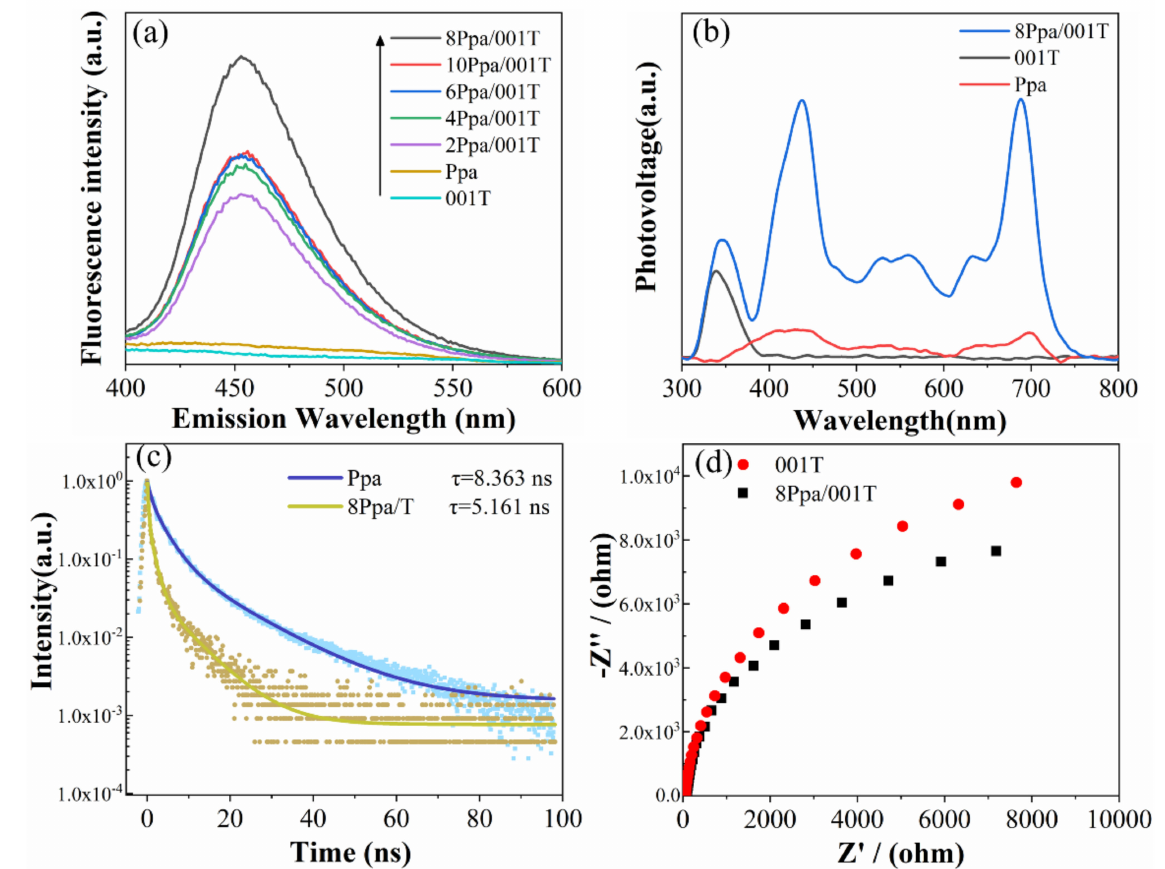
Figure 4. ( a ) FS spectra of the • OH radical over the 001T, Ppa, and xPpa/001T samples; ( b ) SS-SPS responses and ( c ) TR-PL responses of the Ppa and 8Ppa/001T; ( d ) Electrochemical impedance (EIS) spectra of the 001T and 8Ppa/001T